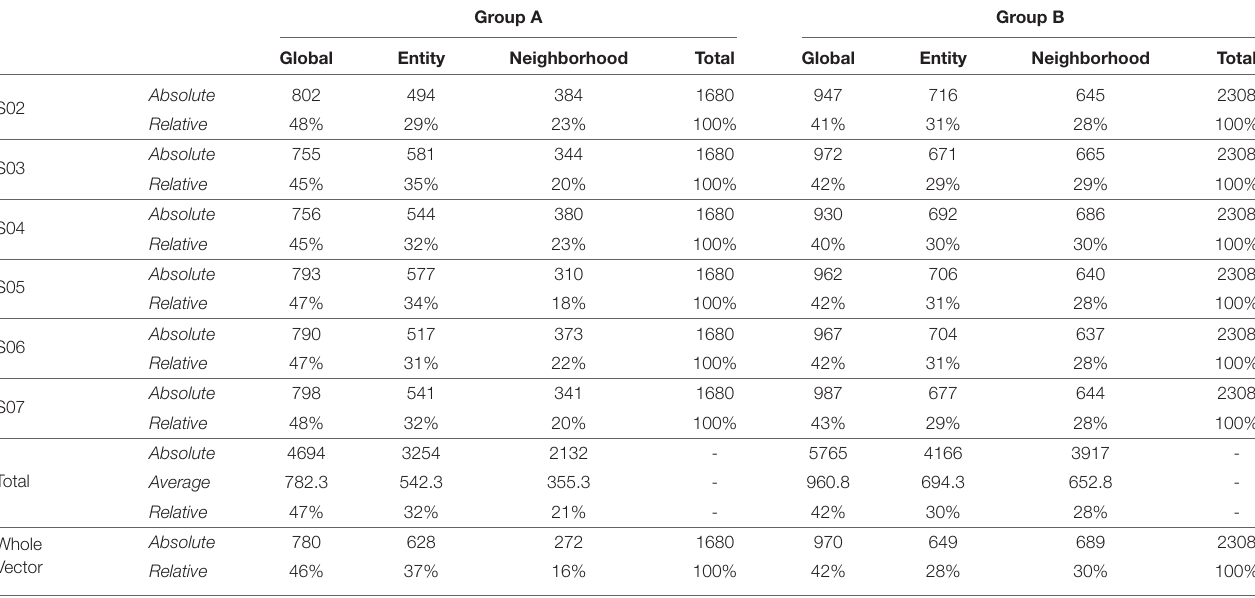
TABLE 4 | Number of invocations for the global and local models by ensemble predictors and whole vector predictor using Thompson Sampling as a sampling